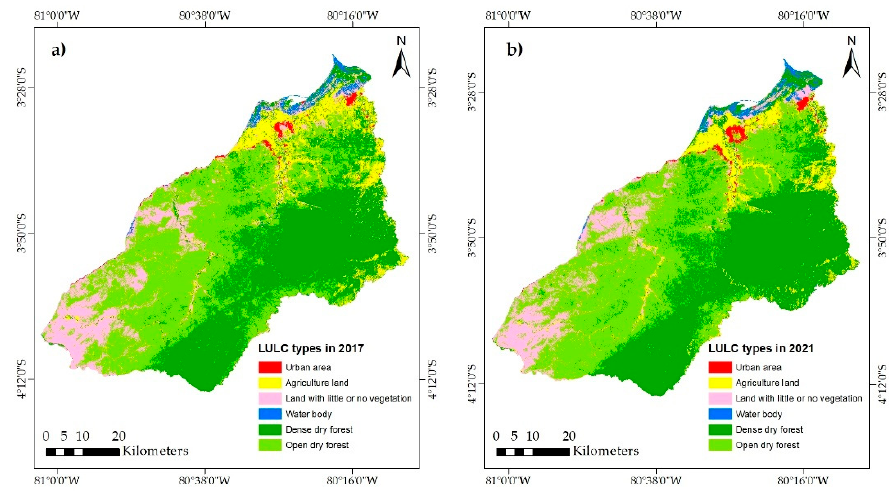
Figure 3. LULC spatial distribution maps for the Tumbes region: ( a ) 2017 and ( b ) 2021.